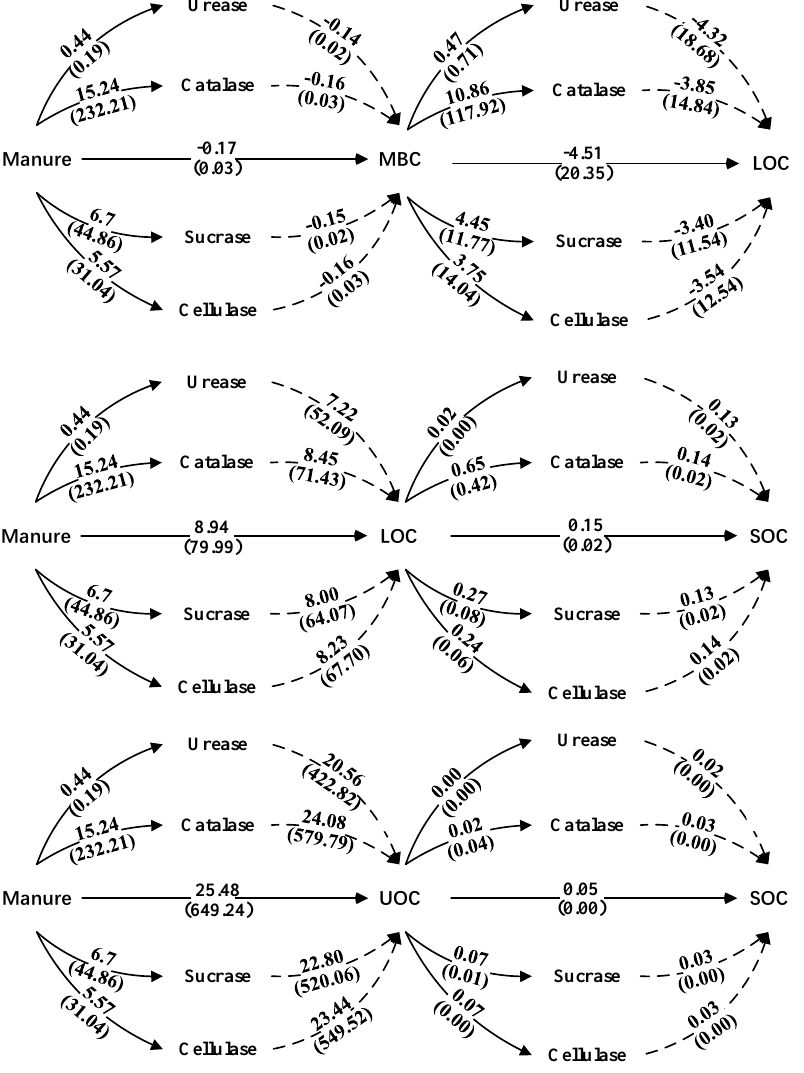
Figure 6. Path analyses between organic manure and activities of four enzymes affecting SOC and the various stable fractions. Solid and dotted lines and values are as described in the legend for Figure 5.